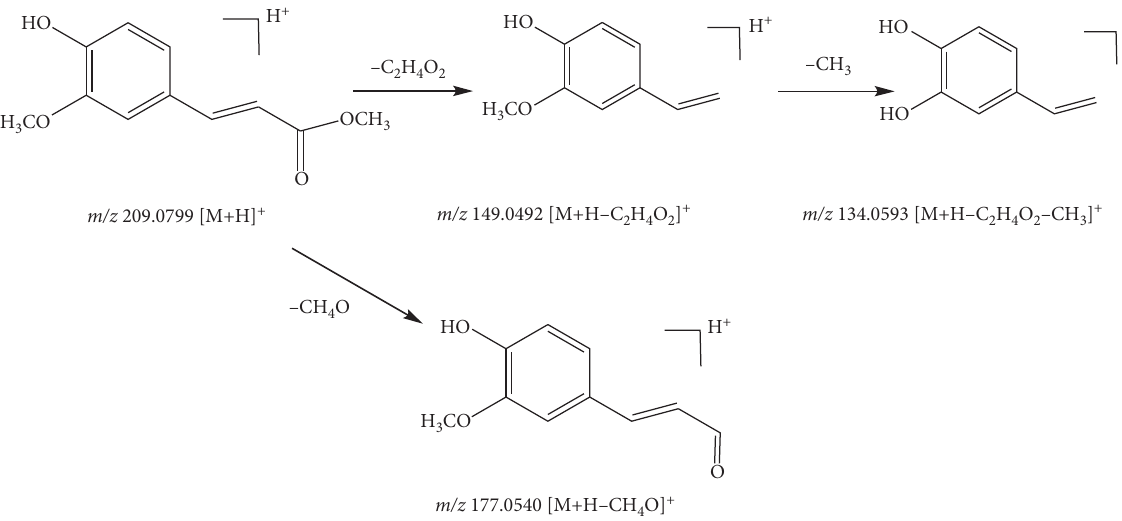
Figure 11: Possible fragmentation pathway of compound 47.